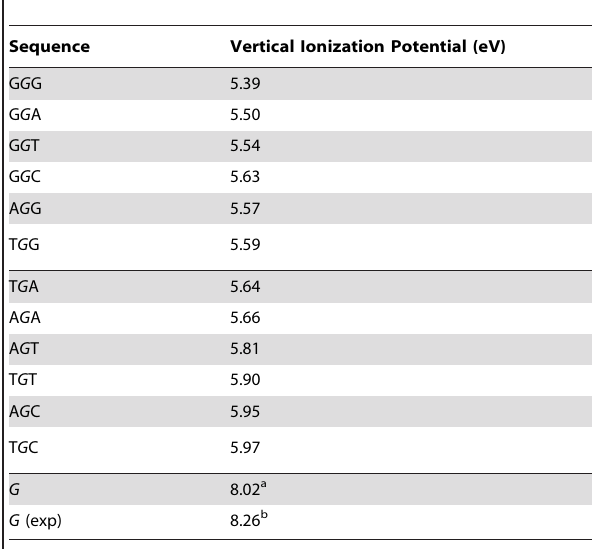
Table 2. Vertical ionization potentials (VIPs) of guanine- centered DGN